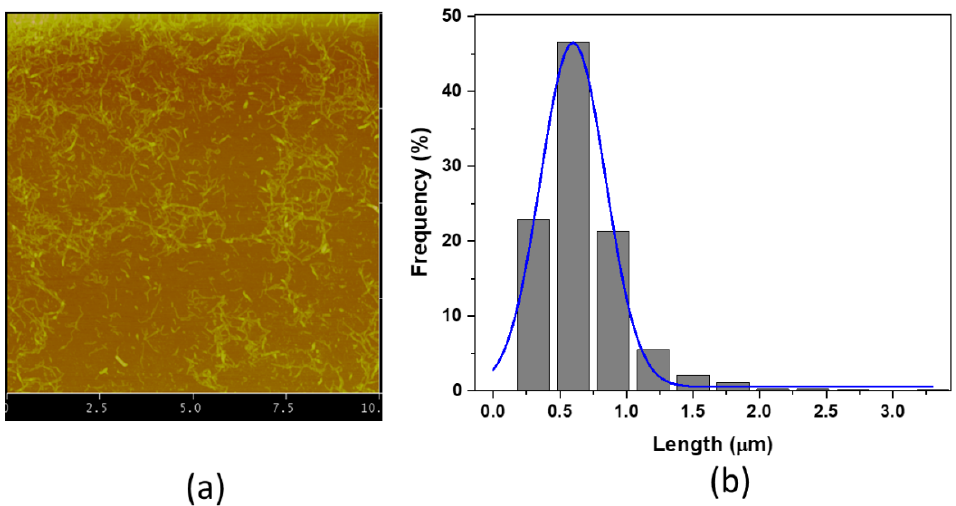
Figure 4. ( a ) An AFM image of the isolated CNF at 60 min TEMPO-oxidation and 30 ACC pass; ( b ) the size distribution in length.